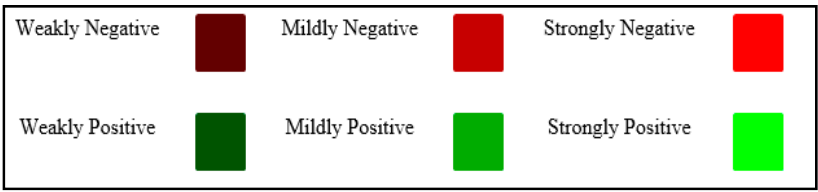
Figure 15. Proposed Tree Map Visualization of Digital Camera 1.